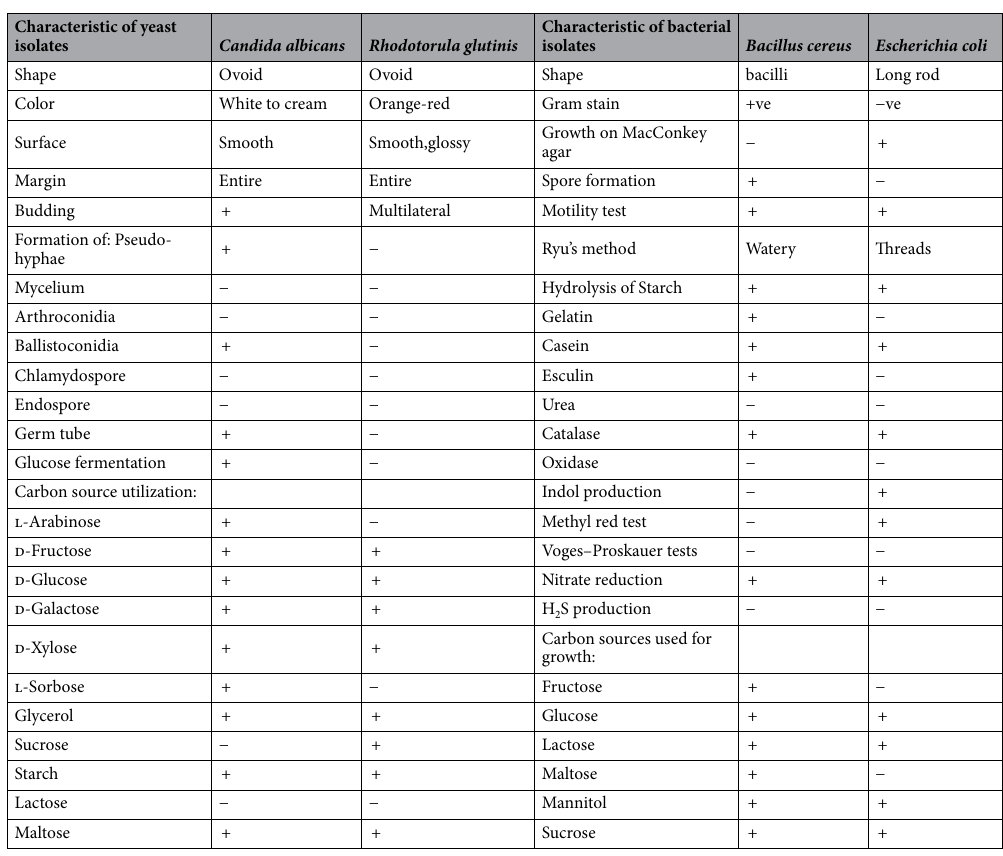
Table 1. Some physiological and biochemical characteristics of Candida albicans, Rhodotorula glutinis, Bacillus cereus, and Escherichia